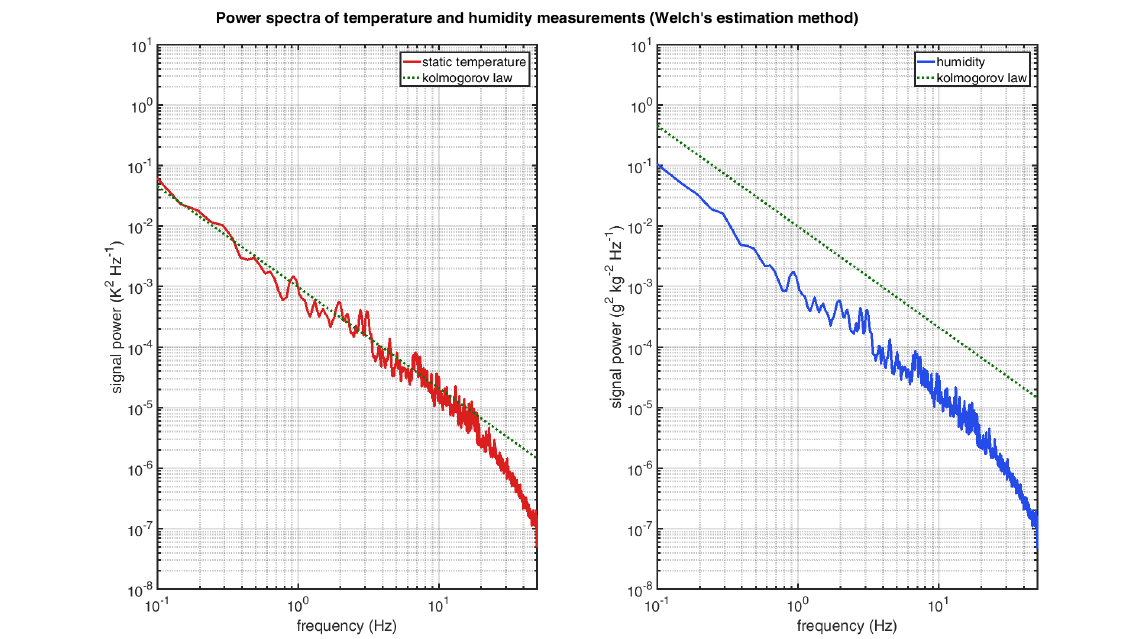
Figure 4. Power spectra of complementary filtered temperature ( left ) and mixing ratio ( right ) using the method of Welch [43] compared to the power law for the inertial subrange of locally isotropic turbulence developed by Kolmogorov [39]. The data were gathered on 2, 10 and 11 July 2016 in Savè (Collines, Benin) during the project Dynamics-aerosol-chemistry-cloud interaction in West Africa (DACCIWA) [27]. Spectra of different straight legs on different days were averaged according to Welch [43].